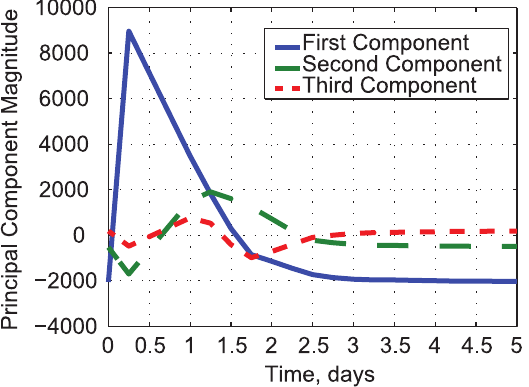
Figure 7. Shapes of the first three cytokine principal compo- nents, y 1 ( t k ), y 2 ( t k ), and y 3 ( t k